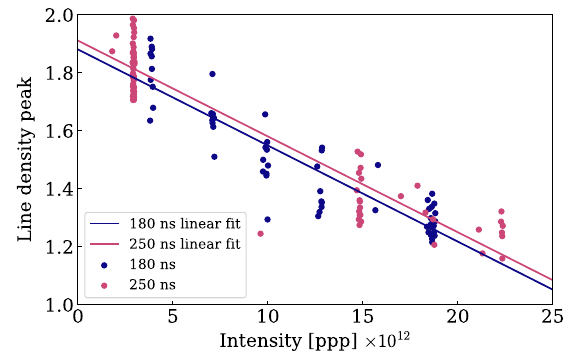
FIG. 11. Normalized line-density modulation along the bunch, showing a decreasing trend with increasing intensity. The colors refer to the different gap duration settings as indicated in the legend, which match the observed gap width well. Independent of the gap duration, the line-density modulation improves with increasing intensity. 63 and 76 acquisitions for 180 and 250 ns are shown, respectively. The least-squares linear fits are plotted to highlight the downward